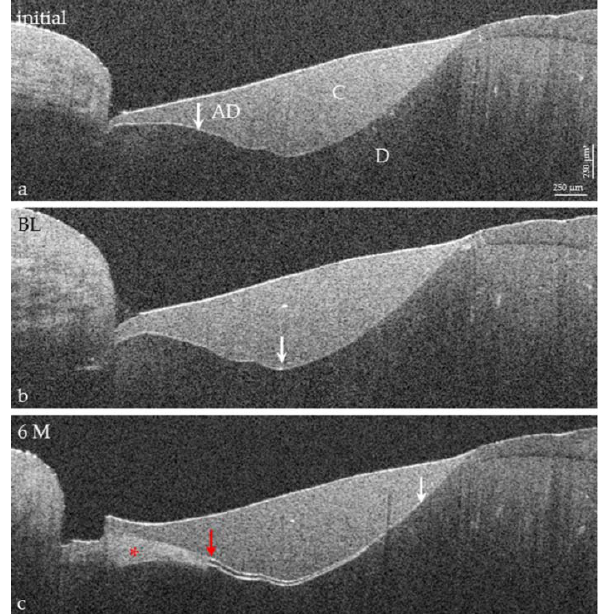
Figure 20. SD ‐ OCT monitoring of tooth ‐ composite bond at a cervical composite restoration (C). Figure 20. SD-OCT monitoring of tooth-composite bond at a cervical composite restoration (C). ( a )